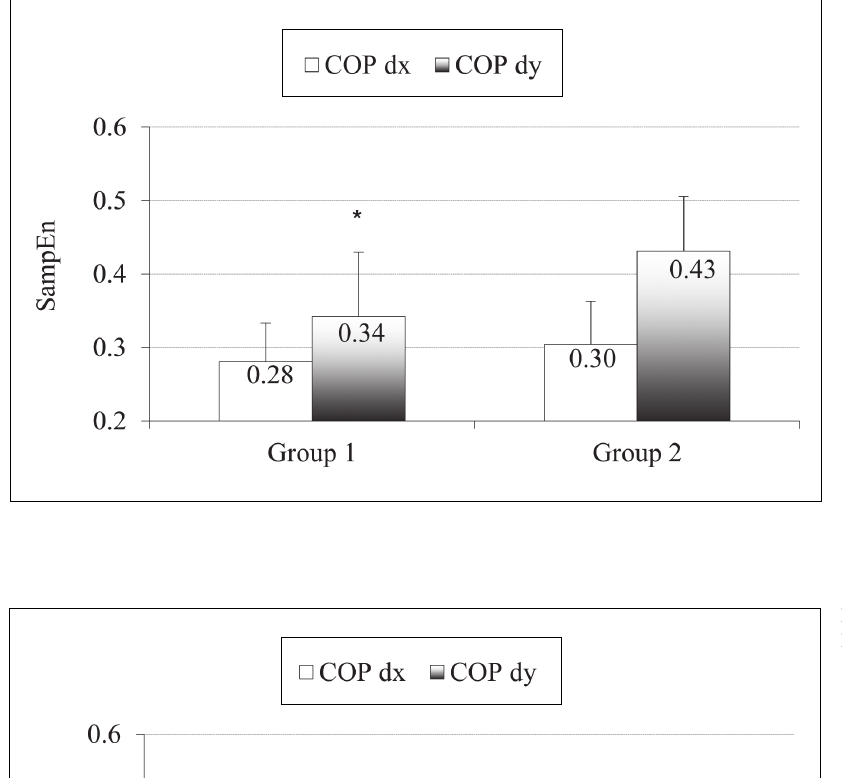
Note. * – p < .01, group 1 compared to group